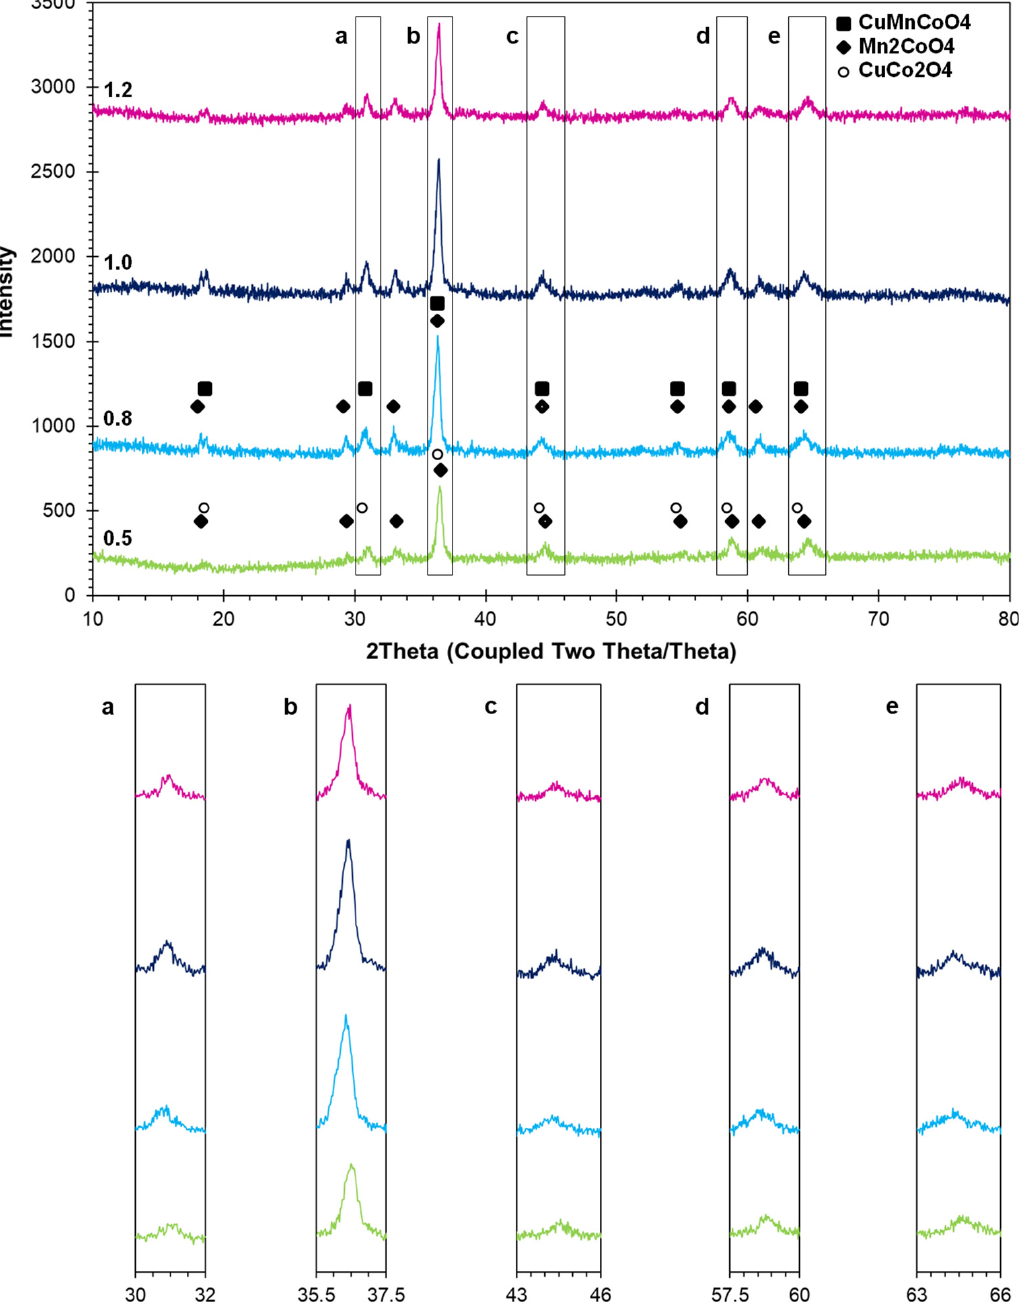
Figure 3. X-ray diffraction patterns for the spinel powders synthesized at different CA/MN ratios.